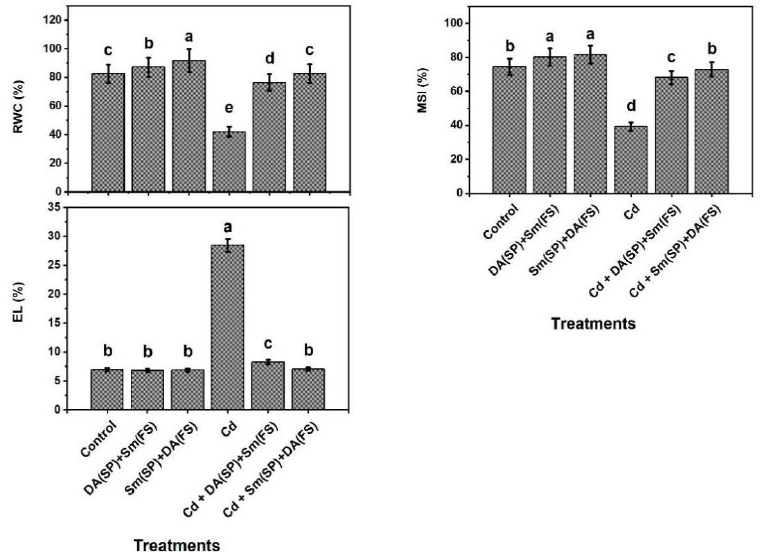
Figure 3. Effects of seed priming (SP) and foliar spraying (FS) with silymarin (Sm) or dopamine (DA) on plant water status of cadmium-stressed Phaseolus vulgaris plants. Columns labeled with same or different letters within each plot signify non-significant or significant differences, respectively, based on LSD test ( p ≤ 0.05). Bars represent SE values (three replicates). RWC = relative water content, MSI = membrane stability index, and EL = electrolyte leakage.